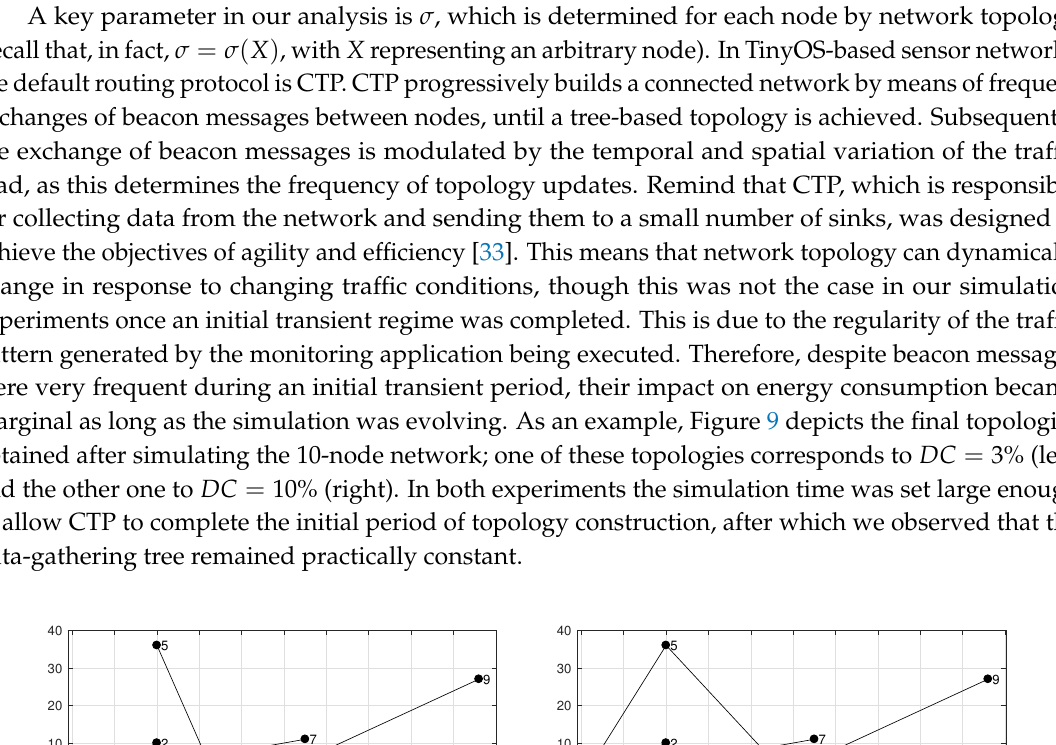
Figure 8. Network deployments used in the simulation tests.